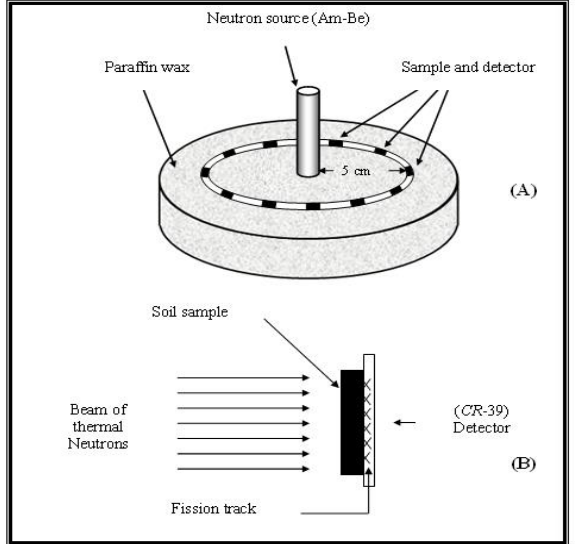
Fig.1: (CR-39) detector for teeth sample